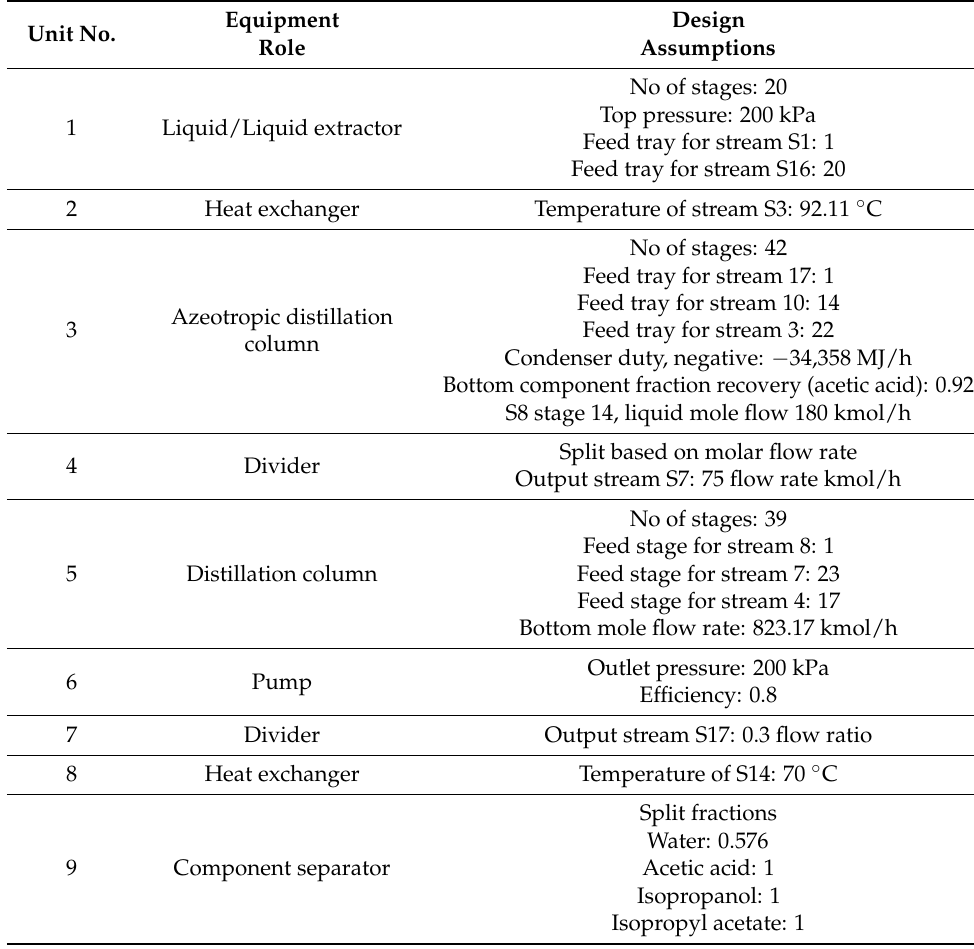
Table 4. Design assumptions for the main units for case 4. Unit